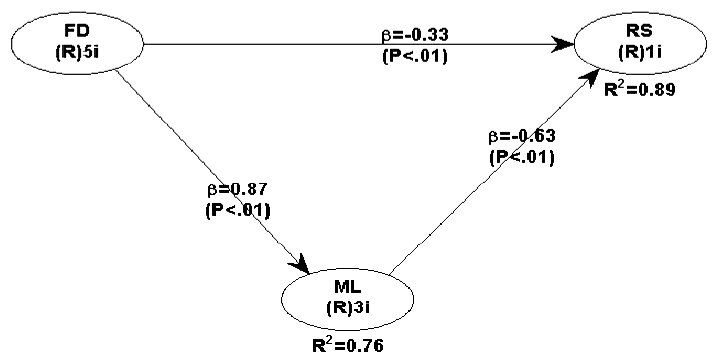
Figure 3: Output of Warp-PLS